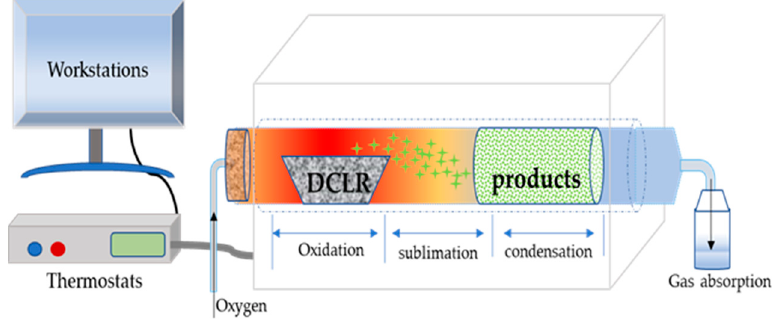
Figure 10. The schematic of the experimental set-up for recycling Mo-based Figure10. The schematic of the experimental set-up for recycling Mo-based catalysts.